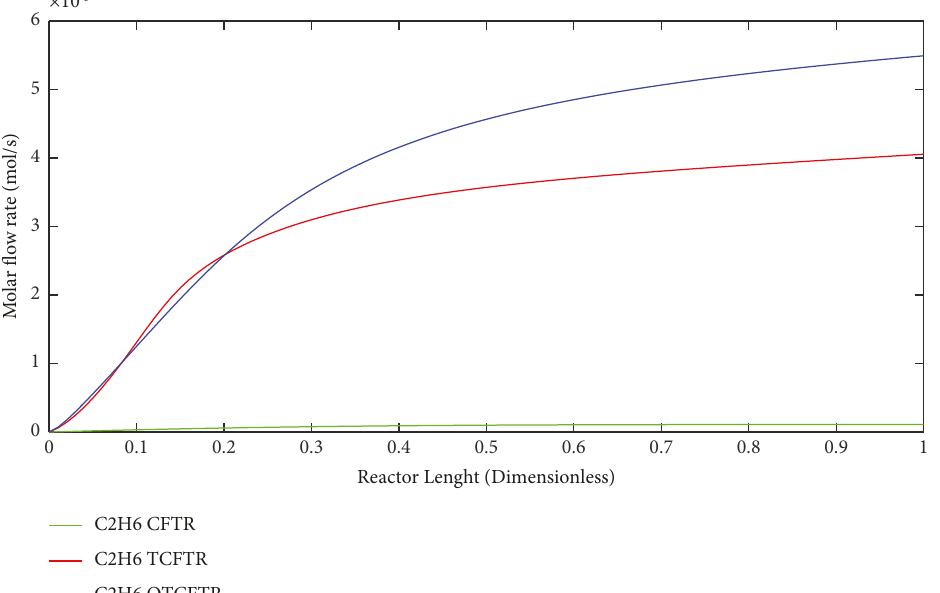
Figure 17: Comparison of the molar flow rate of ethane in the exothermic part of the reactor for CFTR, TCFTR, and